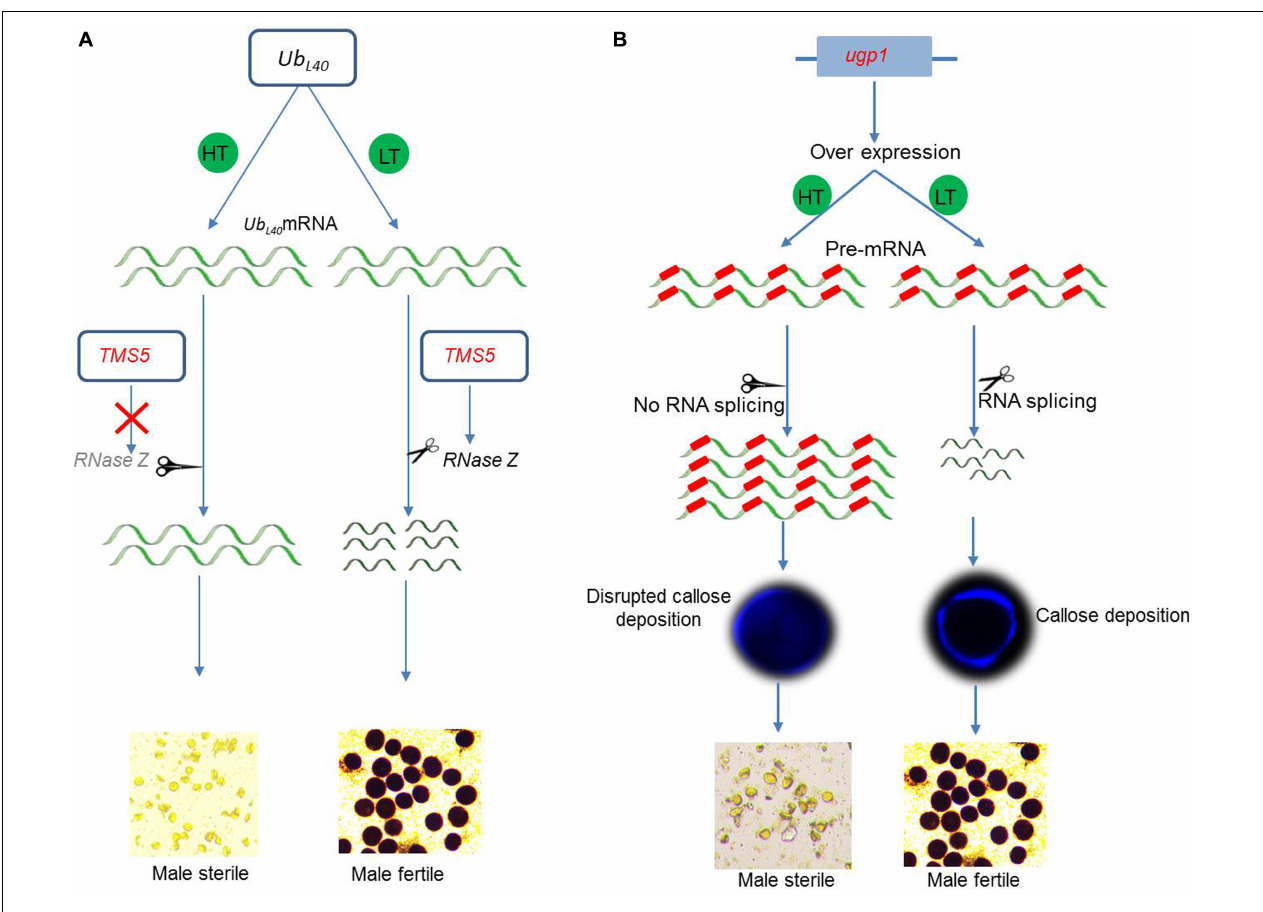
FIGURE 3 | Molecular control of fertility–sterility transition of environment-sensitive genic male sterility (EGMS) genes. (A) TMS5 in TGMS lines encodes RNase Z S 1 , which cleaves Ub L 40 messenger RNA (mRNA). The mutated tms5 does not encode RNase Z S 1 and is unable to cleave Ub L 40 mRNA. Higher accumulation of unprocessed Ub L 40 mRNA causes male sterility under high temperature (HT). Under low temperature, mutated tms5 encodes RNase Z S 1 and cleaves Ub L 40 mRNA to produce fertile pollen. (B) Overexpression plants of UPD-glucose pyrophosphorylase1 ( Ugp1 ) produce abundance of unprocessed aberrant mRNA, which causes male sterility at high temperature (HT). Under low temperature (LT), the mRNA undergoes proper splicing and produces fertile pollen.